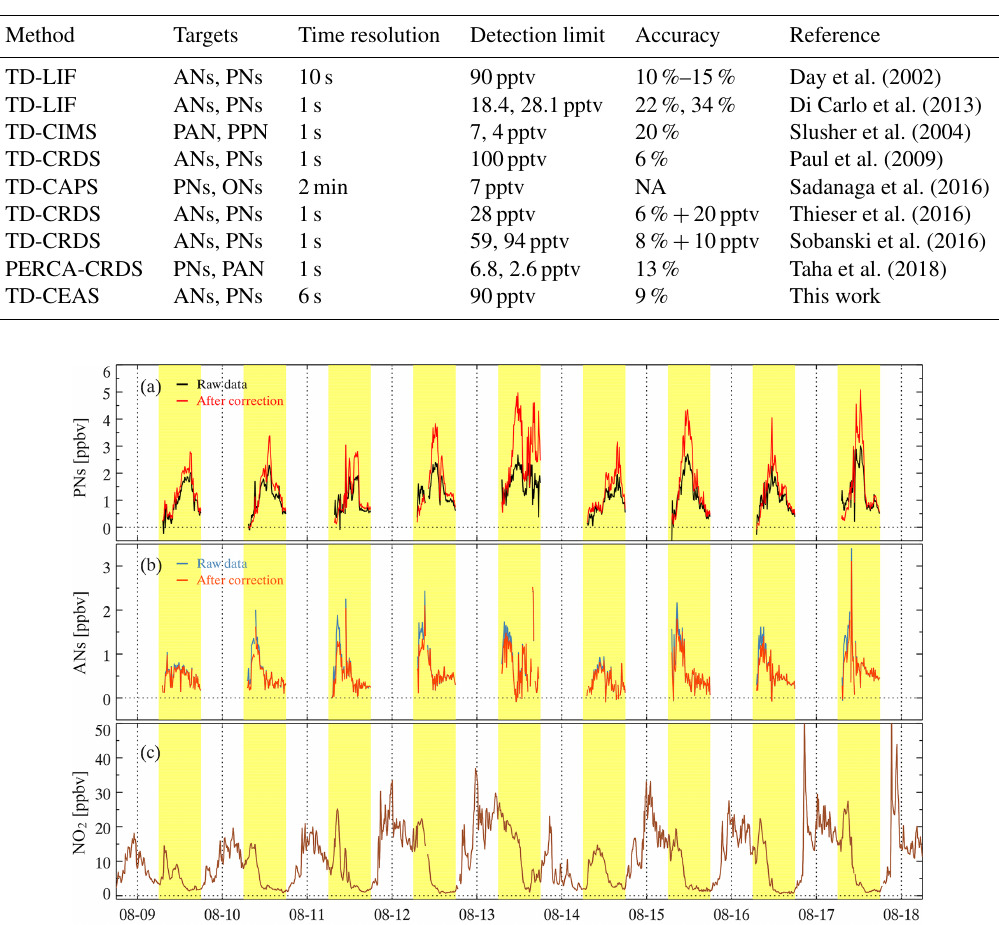
rounding area is lush with trees and is close to a forest